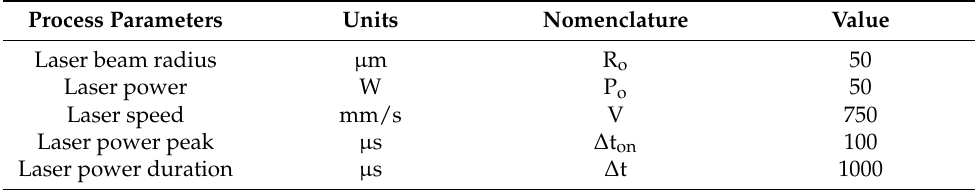
Table 1. Process Parameters. Process Parameters